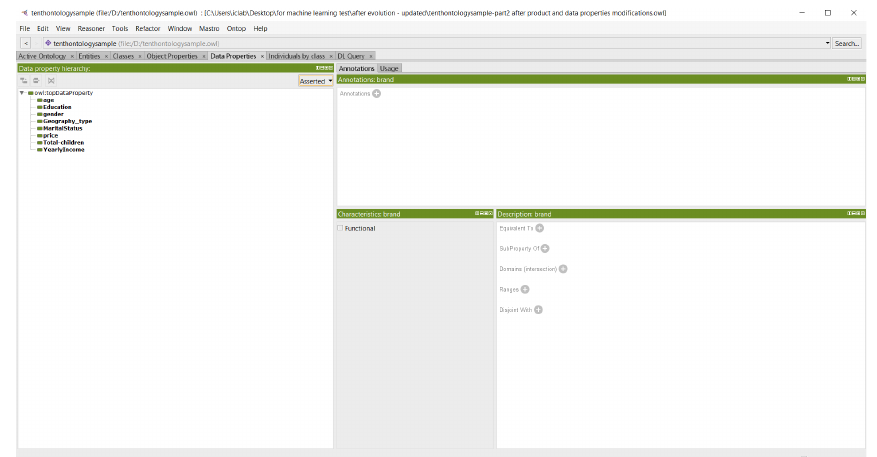
Figure 7. Online retail ontology data properties.